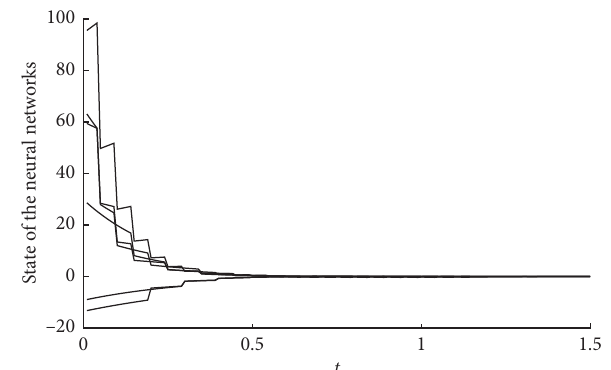
Figure 4: Simulation result for stabilization in Theorem